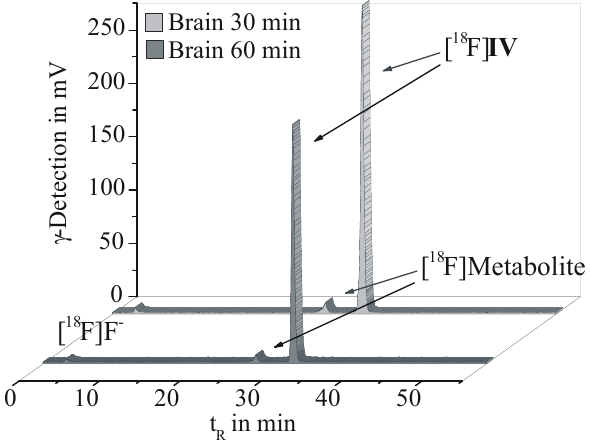
Figure 4. Analytical radio-HPLC results of brain homogenates obtained at 30 and 60 min p.i. of [ 18 F] IV in female CD-1 mice (Reprosil Gold C18 column, gradient elution with 10 to 90% MeCN/H O and 20 mM NH OAc over 55 min, flow rate 1 2 4